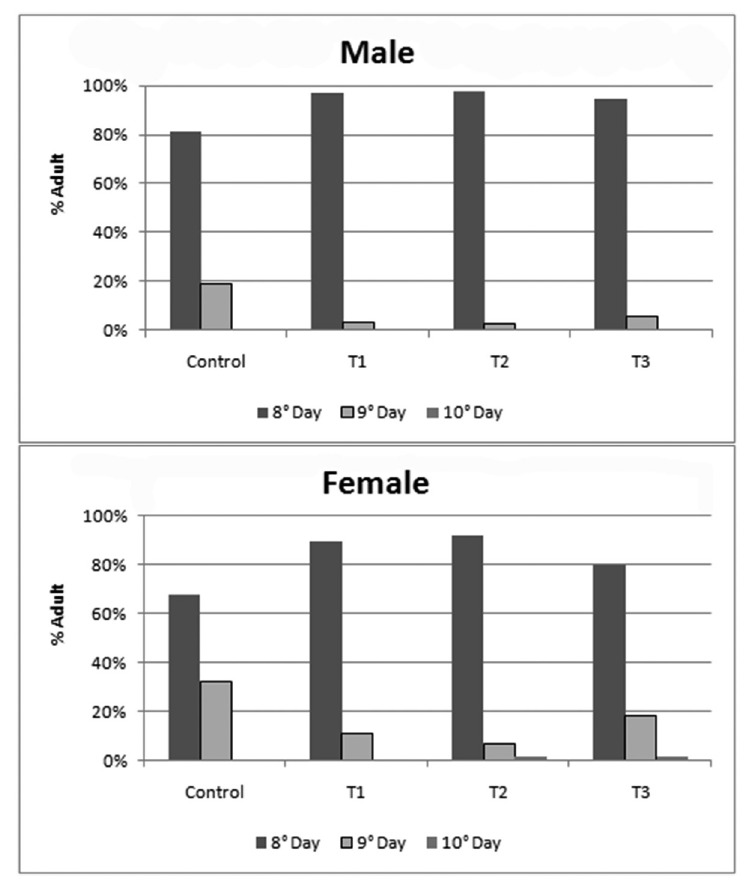
Figure 2 – Rate of emergence, in days, of males and females of Chrysomya putoria (Wiedemann, 1830) subjected to four treatments: control = gizzard homogenate agar; T1 = gizzard homogenate agar + ampicillin 41.66 μ g/mL, T2 = gizzard homogenate agar + ampicillin 81.33 μ g/mL, T3 = gizzard homogenate agar + ampicillin 166.66 μ g/mL.